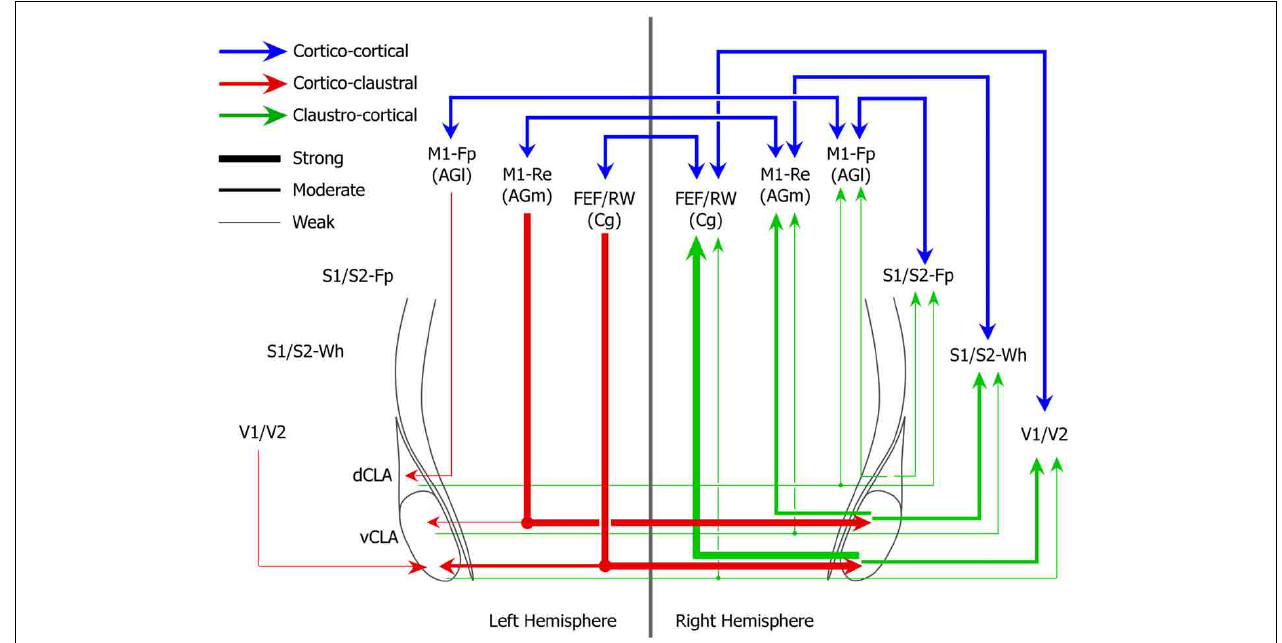
FIGURE 9 | Circuit diagram of interhemispheric sensorimotor cortico-claustro-cortical circuits in rats. Strength of projections are indicated by line thicknesses (see